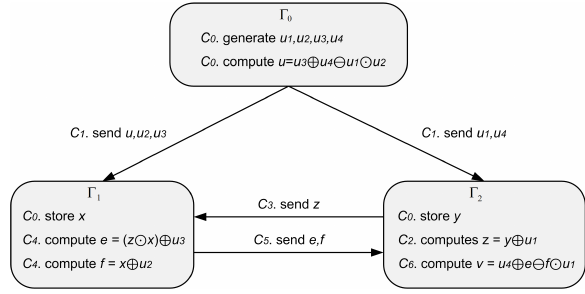
Figure 15: MultShares with threee